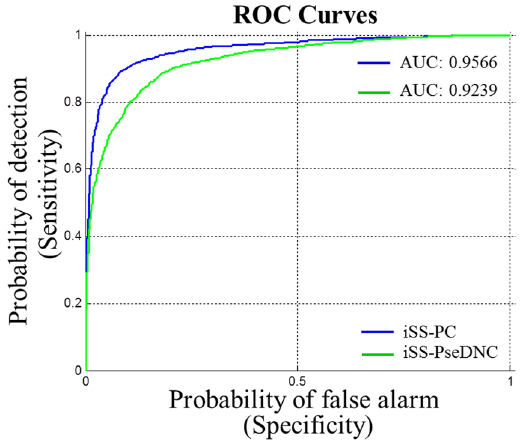
Figure 3. ROC curves of the two different predictors for the splice donor site sequences.